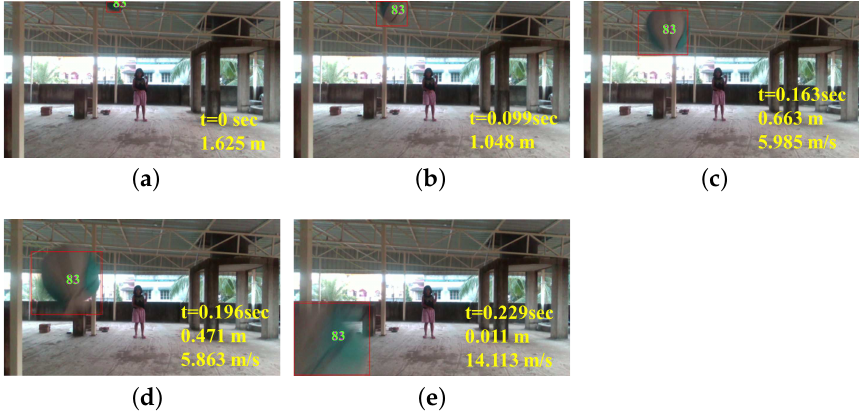
Figure 25. Performance of the proposed tracking algorithm with a very fast-moving obstacle. ( a – e ): Time-sampled snapshots with the results using our proposed